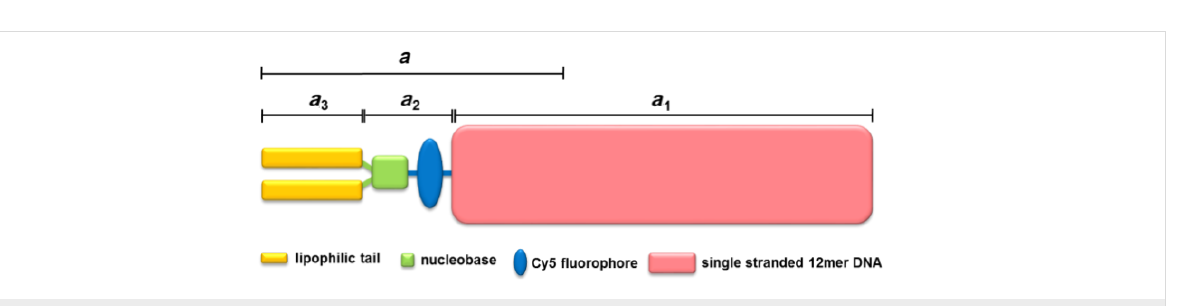
Figure 16: Schematic structure of a Cy5-labeled lipo-oligonucleotide.